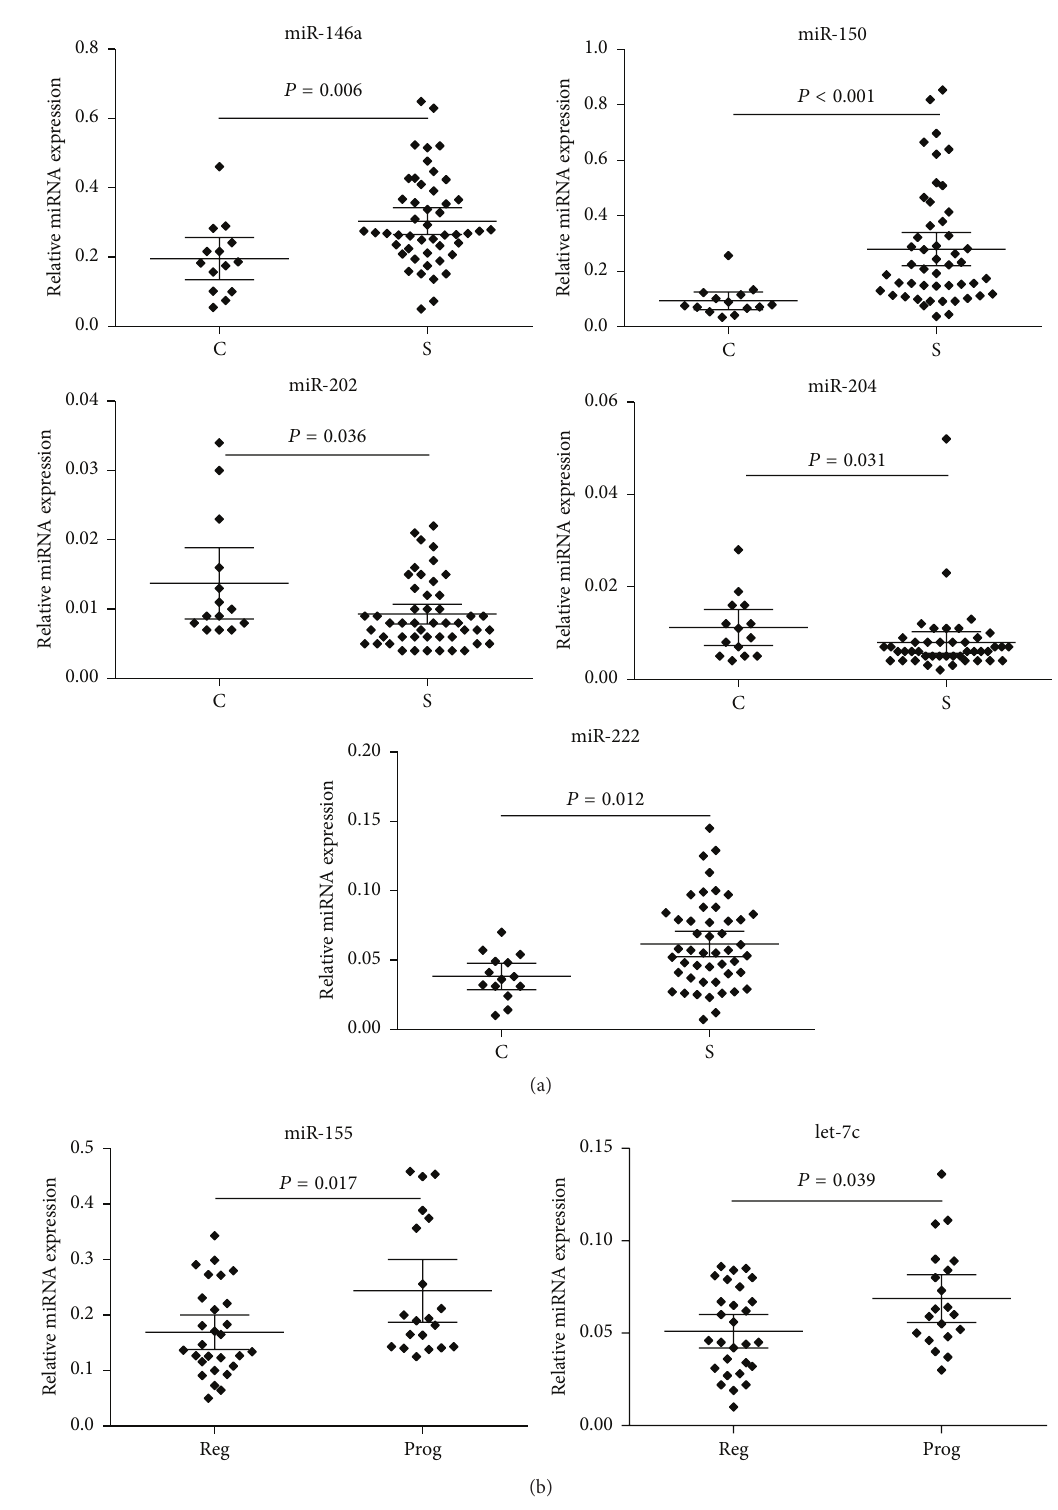
Figure 2: Distribution of relative miRNA expression (ratio target miRNA/reference endogenous U6 miRNA) of (a) five deregulated miRNAs between sarcoidosis patients (S) and control subjects (C) and (b) two deregulated miRNAs between patients with regressing (Reg) and progressing (Prog) sarcoidosis. Group means are indicated by horizontal bars; error bars indicate 95%